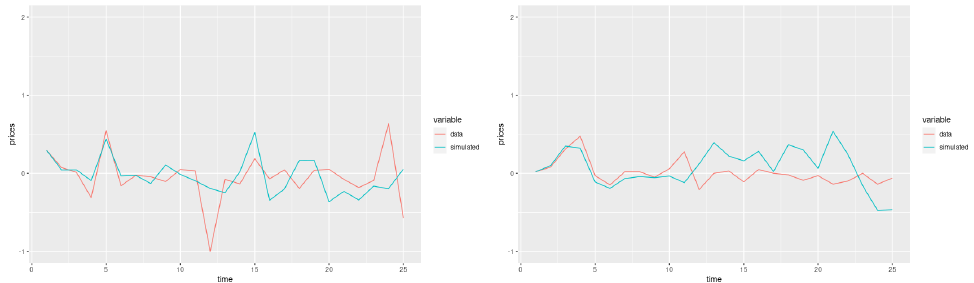
Figure 8. Price trajectories generated by the model (54) vs. the copper price data. Temporal ranges: (i) on the left and (ii) on the right.